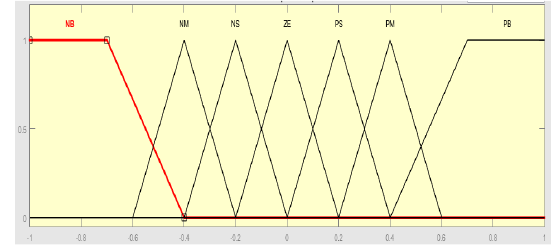
Fig 14a: Error (e) for DC link voltage control